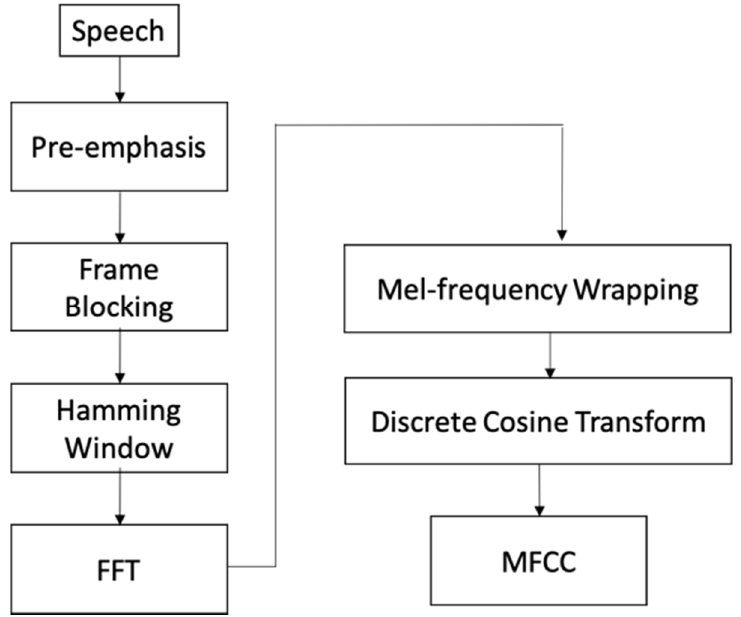
Figure 1. The MFCC calculation